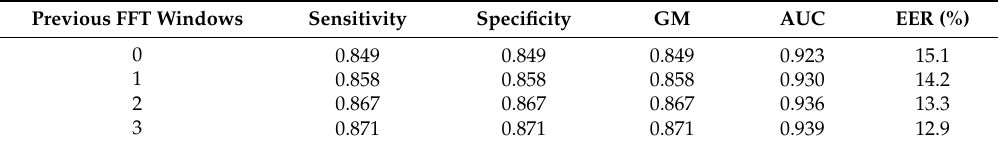
Table 7. Results of the CNN-LSTM model with a di ff erent number of contextual